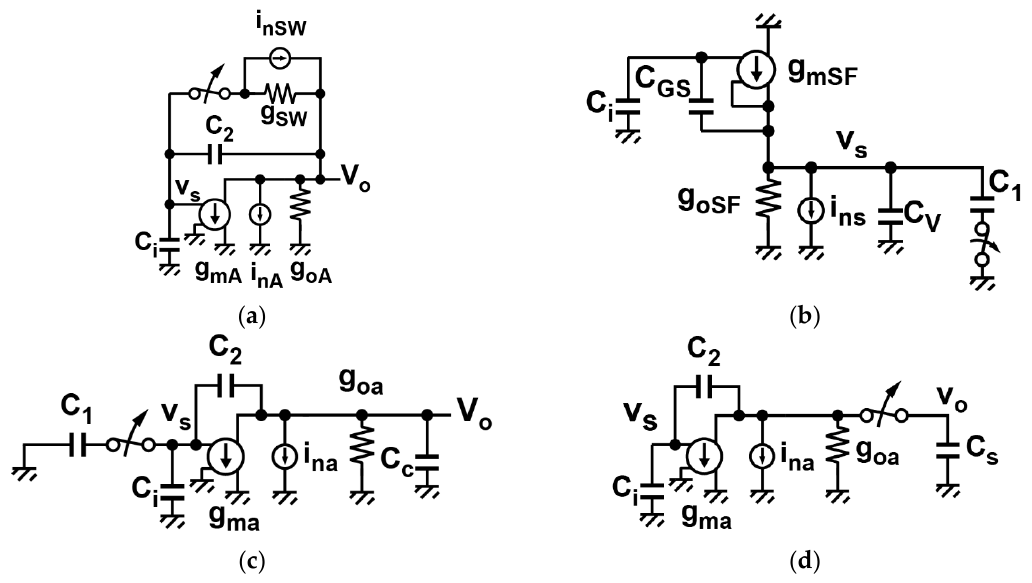
Figure 7. Equivalent circuits for noise calculation at four phases of Figure 3. ( a ) Integrator resetting (Figure 3a); ( b ) input signal sampling (Figure 3b); ( c ) signal charge transfer (Figure 3c); and ( d ) integrator output sampling for ADC (Figure 3d).